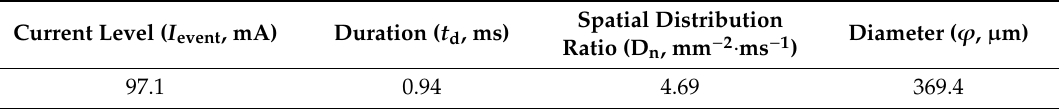
Table 1. Estimated characteristic parameters of individual discharge